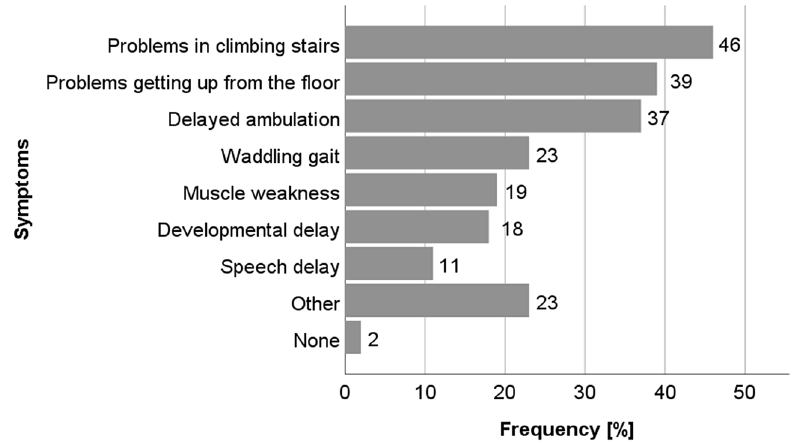
Figure 1. First symptoms of Austrian